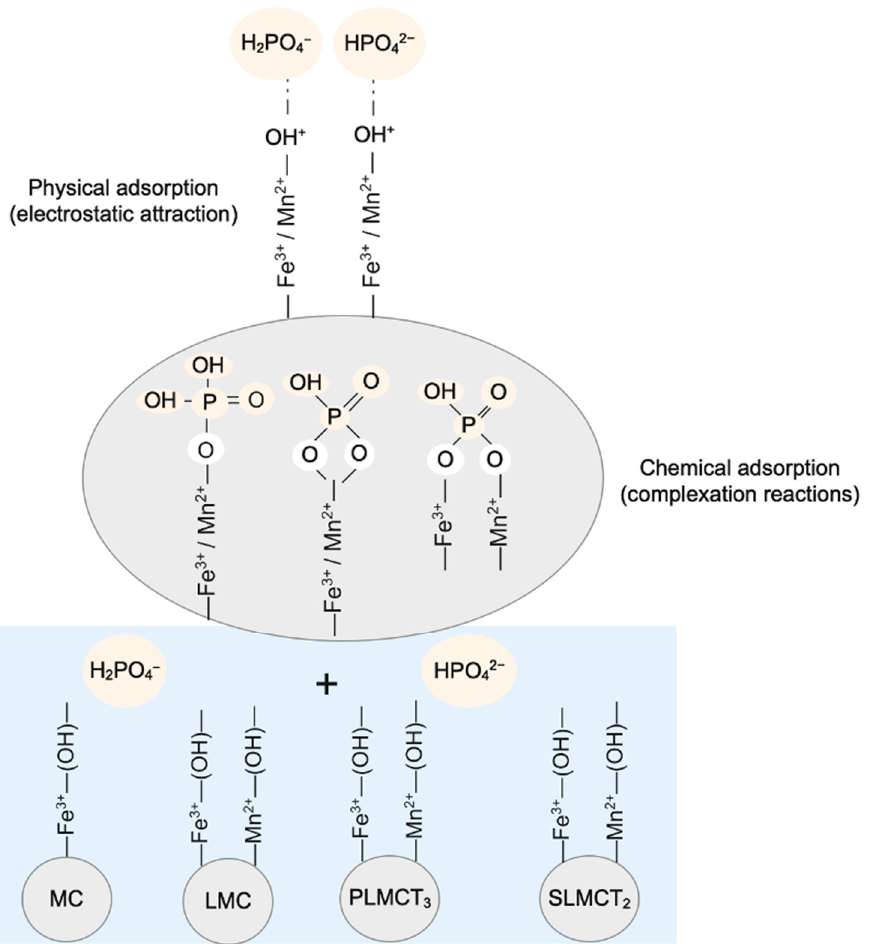
Figure 7. Governing mechanisms of phosphate adsorption onto the loaded Fe 3+ /Mn 2+ muscovite/zeolite composites (powder, pellets and monoliths). Schematical representation of the phosphate adsorption.